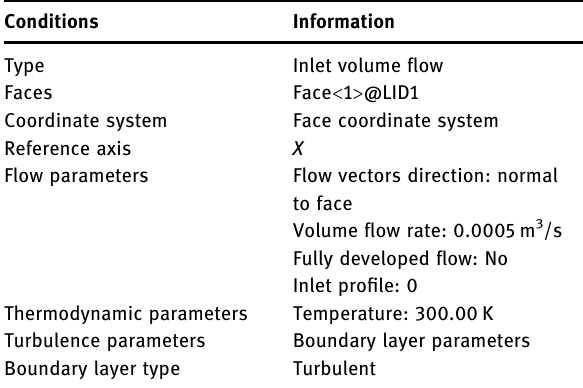
Table 3: Boundary conditions: inlet volume fl ow 1